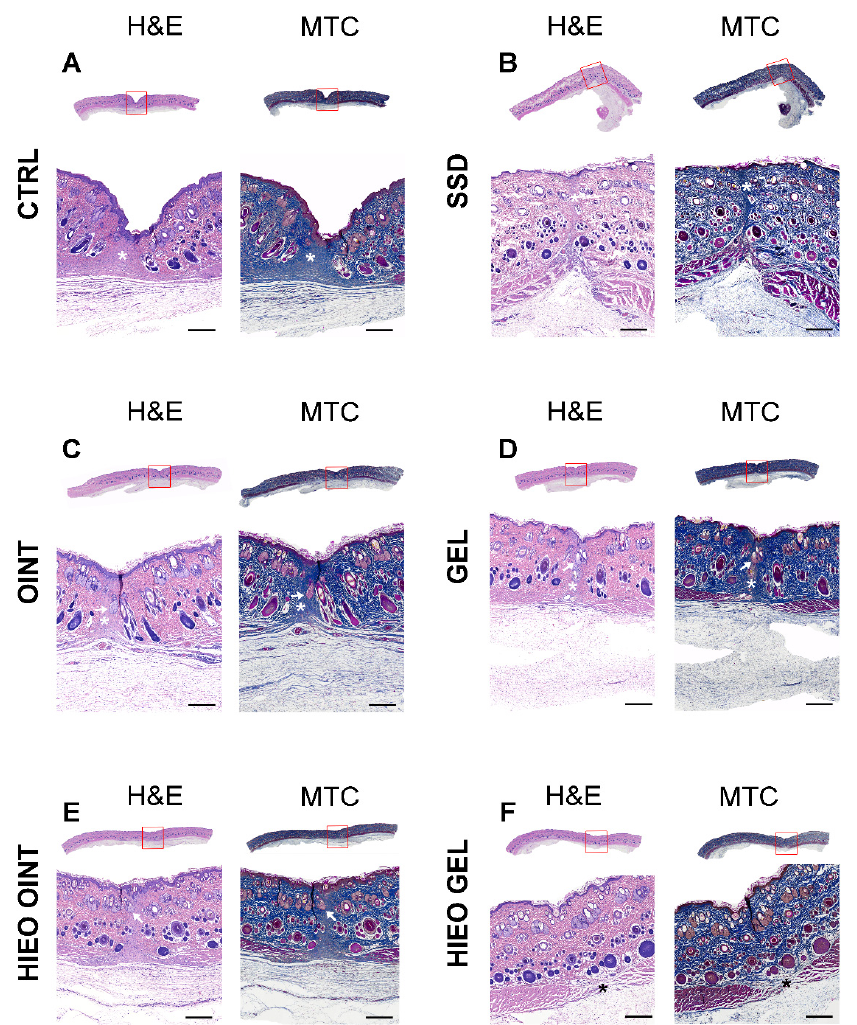
Figure 6. Representative pictures of hematoxylin-eosin (H&E) and Masson Trichrome (MRC) stained tissue sections from CTRL group ( A ), SSD group ( B ), OINT group ( C ), GEL group ( D ), HIEO OINT group ( E ) and HIEO GEL group ( F ). Scale bar, 1 mm.